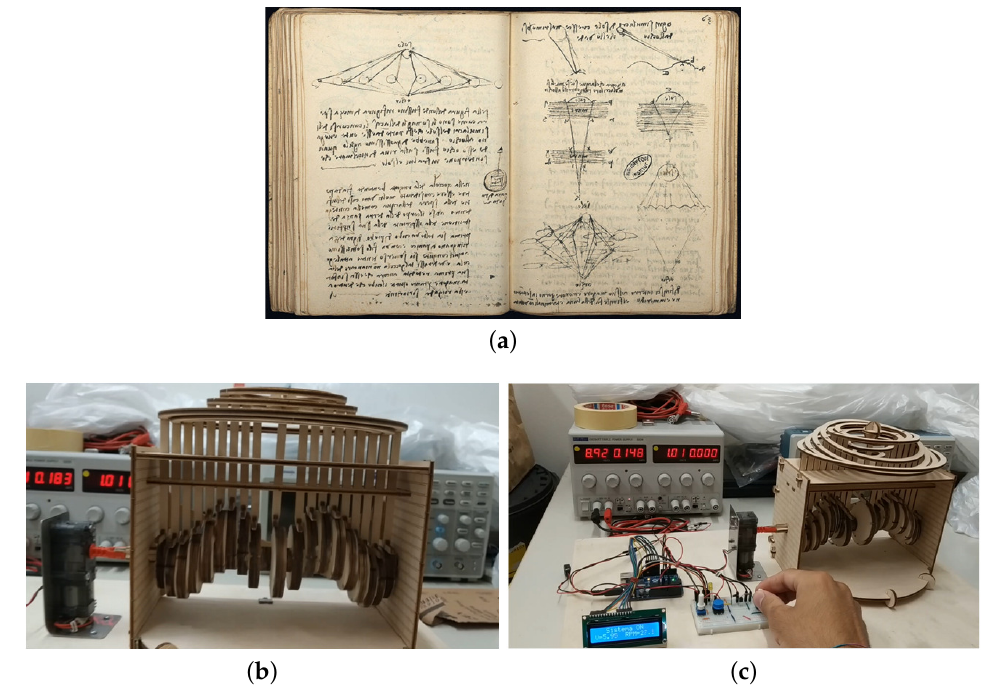
Figure 1. Machine 1, the Drop Propagation: Leonardo’s Codex Leicester ( a ); drop propagation automata ( b ); automated drop propagation model ( c